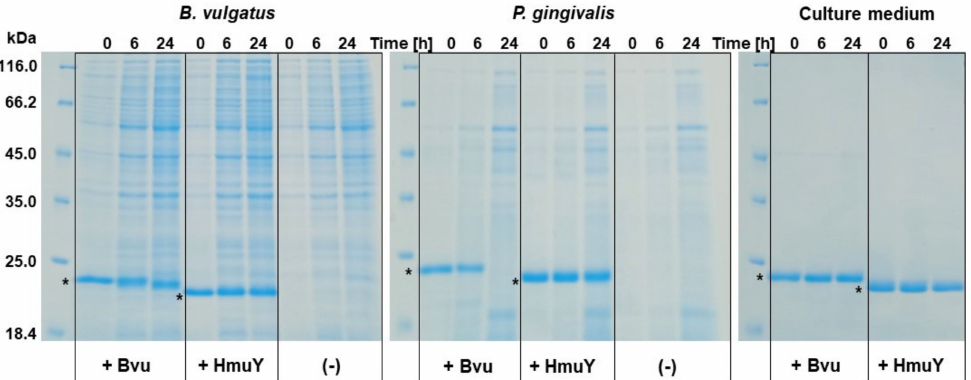
Figure 10. Susceptibility of B. vulgatus Bvu protein to bacterial proteases. Proteolytic digestion was examined by growing bacteria under high-iron/heme conditions in the presence of purified HmuY or Bvu proteins (marked with asterisks). Samples collected at indicated time points were separated by SDS-PAGE and proteins stained with